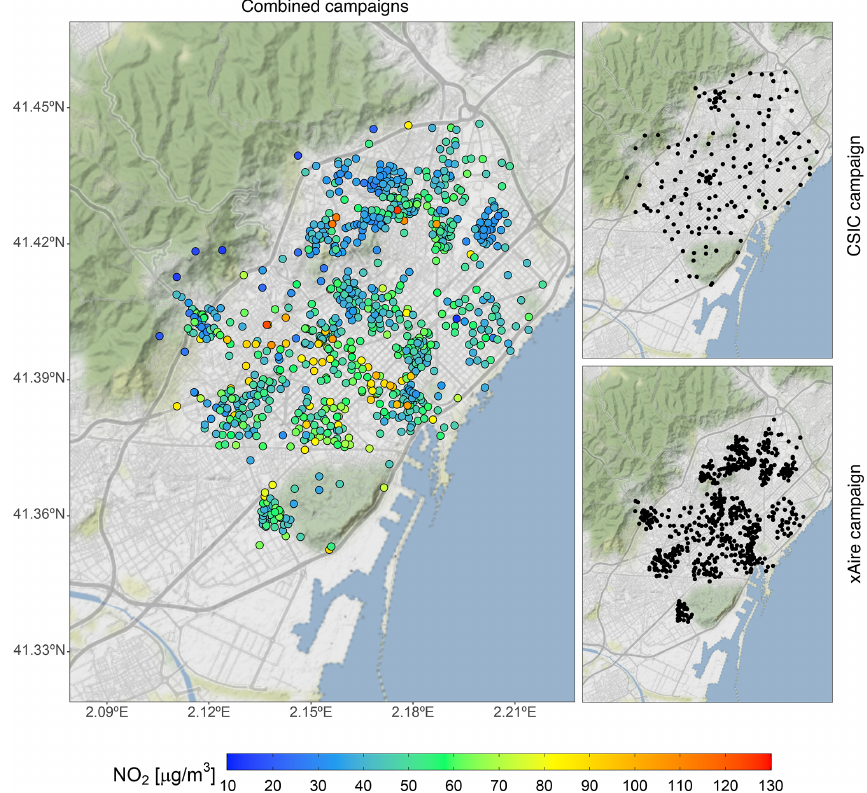
Figure 3. Sampler locations of the two different NO 2 experimental campaigns used to train the microscale LUR model. The left panel shows the NO 2 values and the locations of the combined campaigns. The top-right and bottom-right panels show the CSIC and xAire campaign locations, respectively. The color scale refers to the 2017 annualized NO 2 values (in µgm − 3 ). The map has been generated using ggplot2 (Wickham, 2016) and ggmap (Kahle and Wickham, 2013) R packages (R Core Team, 2013) and data from OpenStreetMap. © OpenStreetMap